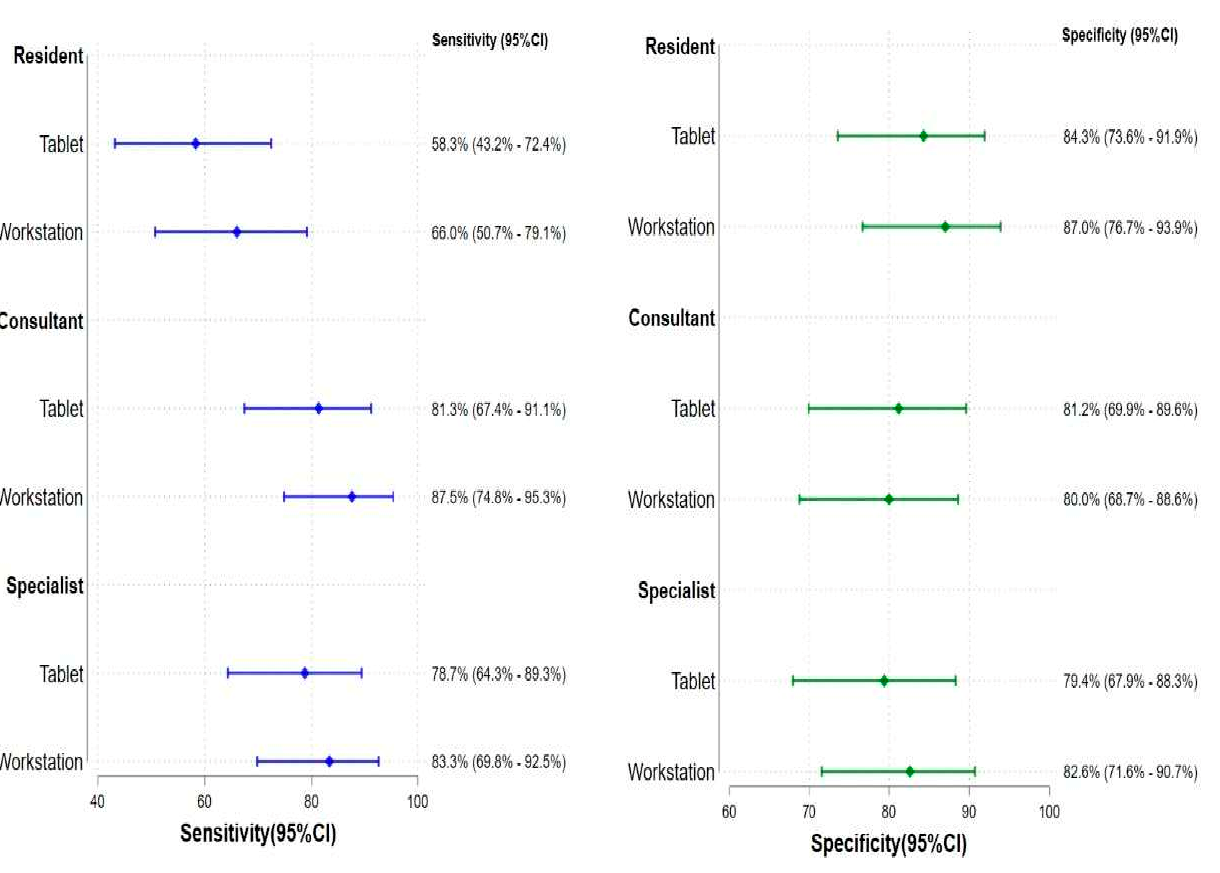
Figure 3. Diagnostic performances between Workstation and Tablet. p -value was performed using McNemar’s test for comparing Se and Sp between workstation and tablet.